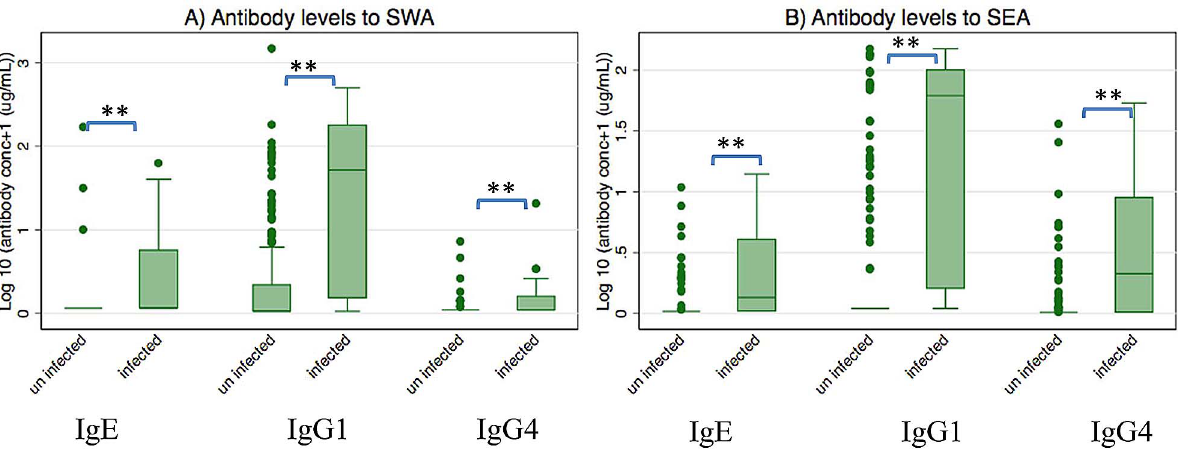
Figure 3. Antibody levels to SWA or SEA among children at age five years. Shown are plasma levels of antibodies to SWA (A) or SEA (B) among uninfected children (n=390) and infected children (n=20) at age five years. ** Wilcoxon rank-sum test p , 0.001.